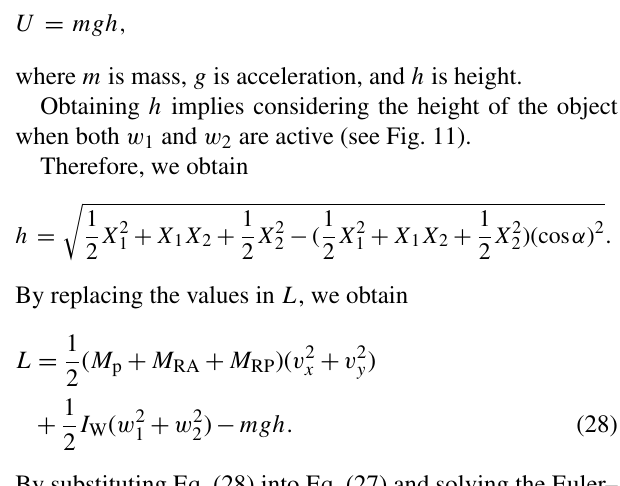
Figure 8. Mobile platform